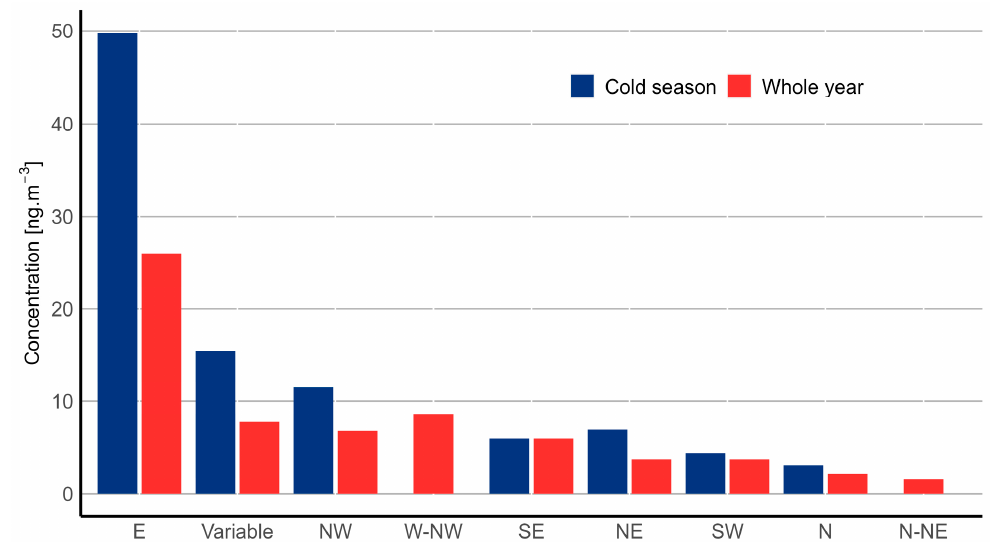
Figure 16. Average BaP concentrations divided into individual daily types of wind, V ěřň ovice sta- tion, 2020.